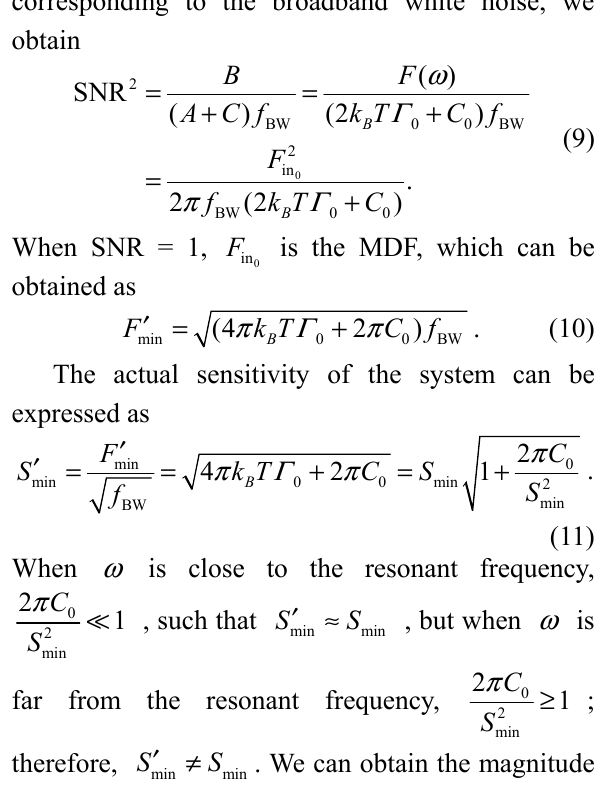
F and U 0 (logarithmic 0 in